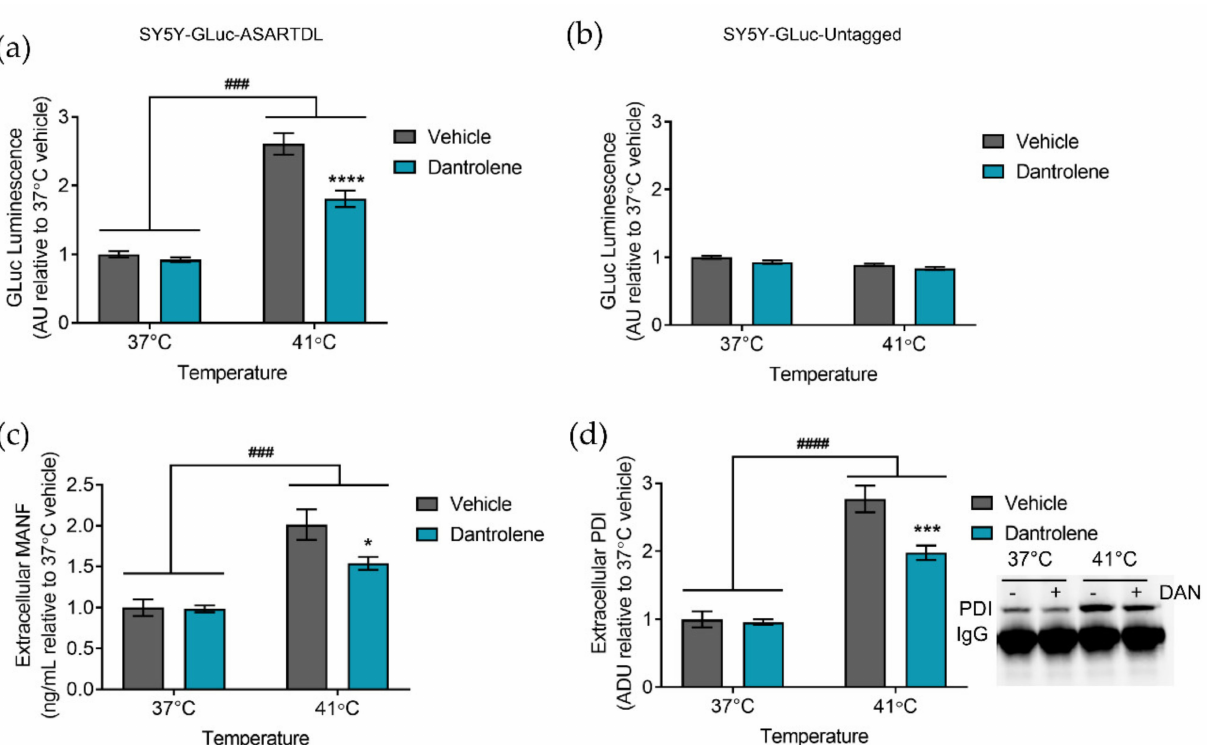
Figure 2. Blocking ER calcium efflux attenuates hyperthermia-induced ER-resident protein secretion. ( a , b ) GLuc (arbitrary units: AU) in the media from SH-SY5Y cells stably expressing either ( a ) GLuc- ASARTDL or ( b ) GLuc-Untagged after a 16 h pre-treatment with 3 µ M dantrolene followed by a 24 h incubation at 37 ◦ C or 41 ◦ C (mean ± SEM, n = 12, two-way ANOVA with Dunnett’s multiple comparisons, ### p < 0.001 37 ◦ C vs. 41 ◦ C, **** p < 0.0001 vehicle vs. dantrolene). ( c ) Fold change in extracellular MANF from SH-SY5Y cells following a 16 h pre-treatment with 3 µ M dantrolene and 24 h exposure to 37 ◦ C or 41 ◦ C (mean ± SEM, n = 3, two-way ANOVA with Sidak’s multiple comparisons, ### p < 0.001 37 ◦ C vs. 41 ◦ C, * p < 0.05 vehicle vs. dantrolene). ( d ) Fold change in arbitrary density units (ADU) of immunoprecipitated PDI (representative blot shown) from the media of SH-SY5Y cells following a 16 h pre-treatment with 3 µ M dantrolene and 24 h exposure to 37 ◦ C or 41 ◦ C (mean ± SEM, n = 6, two-way ANOVA with Sidak’s multiple comparisons, #### p < 0.0001 37 ◦ C vs. 41 ◦ C, *** p < 0.001 vehicle vs.